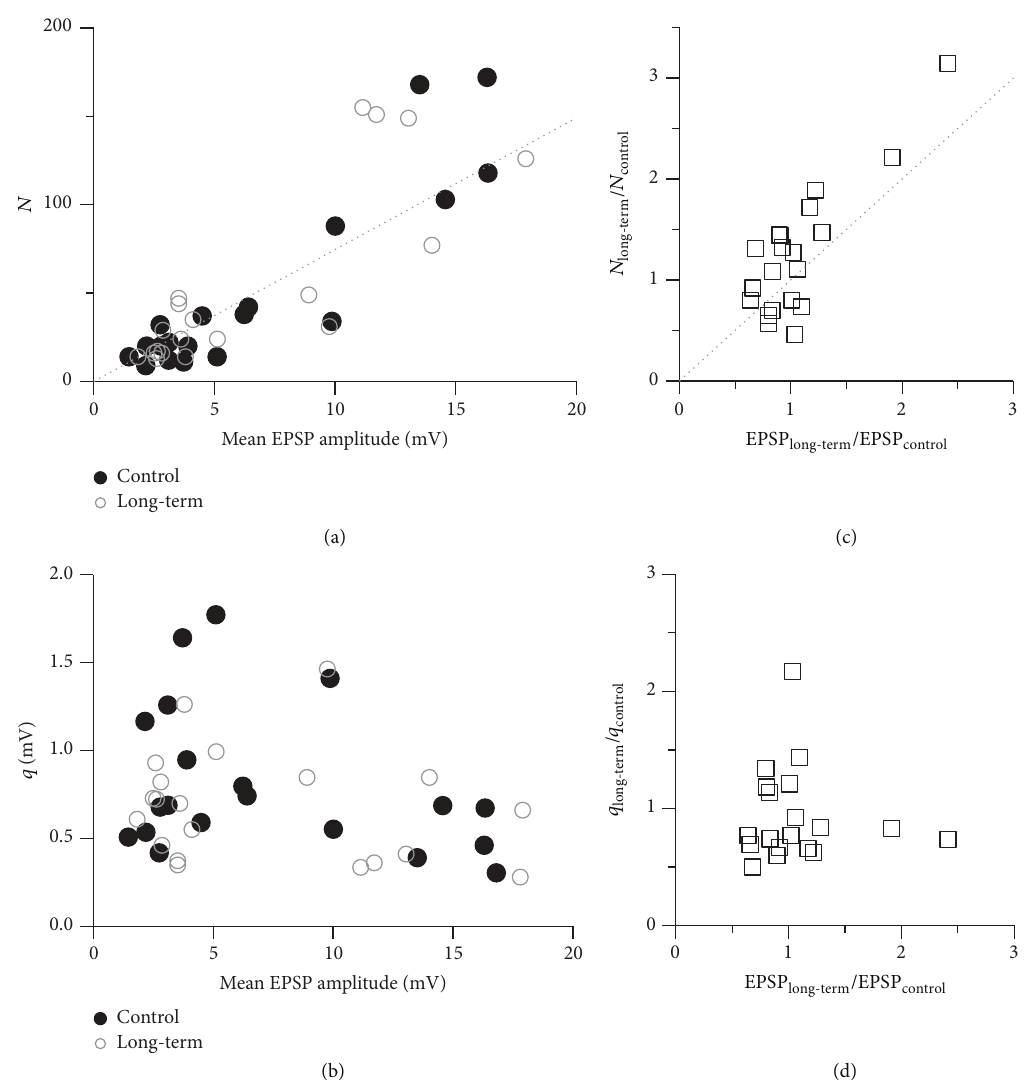
Figure 6: Plasticity induction relies on changes in 𝑁 . Population quantal analysis of the synaptic connections from the SBS experiments. (a) The numbers of release sites 𝑁 were strongly correlated with the synaptic efficacy at both the control ( 𝑟 = 0.91 , 𝑃 < 0.01 ) and long-term ( 𝑟 = 0.82 , 𝑃 < 0.01 ) measurement phases. The dotted line represents the linear relation between 𝑁 and EPSP amplitude (see (1) in Section 2) + 𝑝 )/2 = 0.265 )/2 = 0.80 mV and the averaged release probability ⟨𝑝⟩ = (𝑝 for the averaged quantal size ⟨𝑞⟩ = (𝑞 control + 𝑞 long-term control long-term resulting from the quantal analysis: 𝑁 = ( Mean EPSP )/(⟨𝑝⟩⟨𝑞⟩) . (c) Scatterplot of the relative change in the number of release sites 𝑁 versus the observed relative plasticity. There is a strong correlation ( 𝑟 = 0.83 , 𝑃 < 0.01 ). (b, d) In contrast, the quantal sizes 𝑞 and the relative change in their sizes were not correlated with the synaptic efficacies and the observed relative